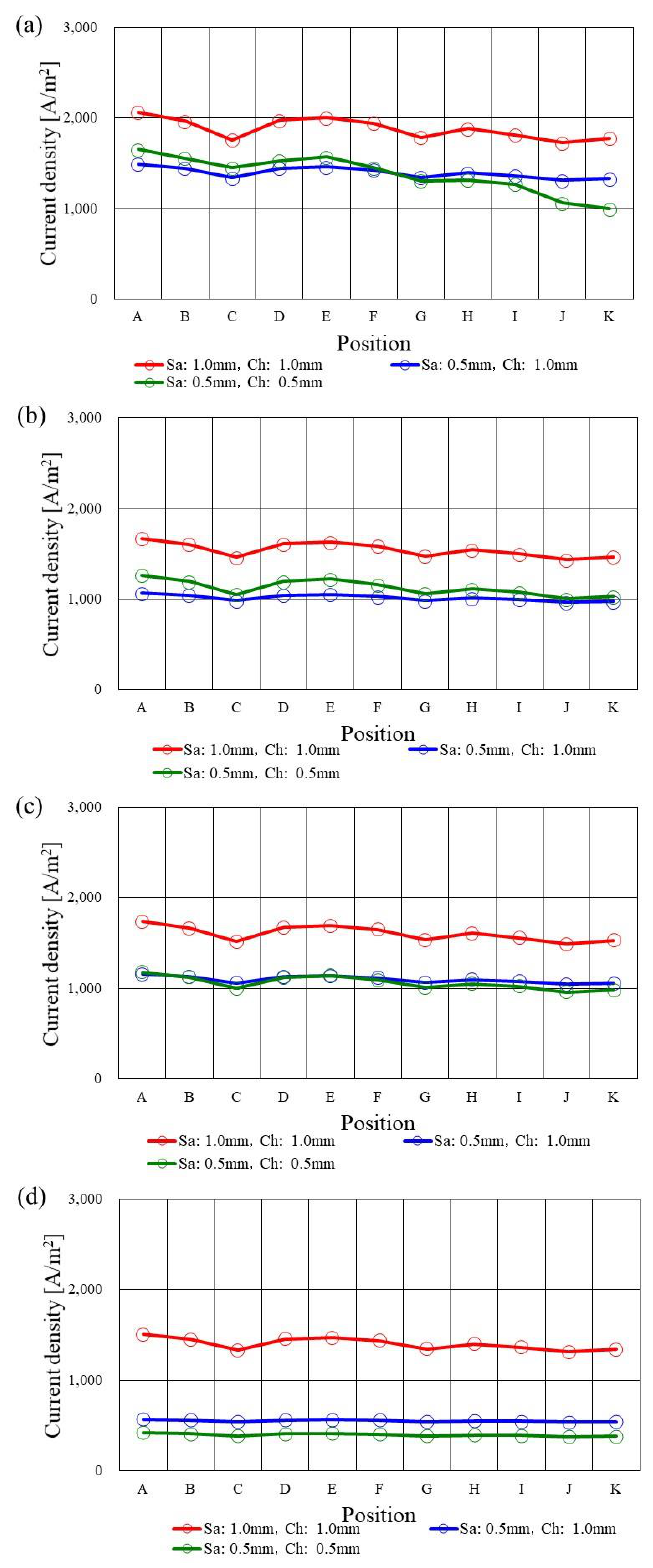
Figure 11. Current density along with the gas channel on the interface between PEM and catalyst layer at the cathode among various s.t. at T ini = 353 K. ( a ) A80%RH/C80%RH, ( b ) A80%RH/C40%RH, ( c ) A40%RH/C80%RH, ( d )